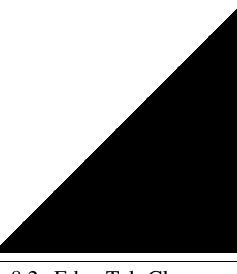
Fig. 8. 256 × 256 px Image Comparison Table 2. Nearness Measures comparison.